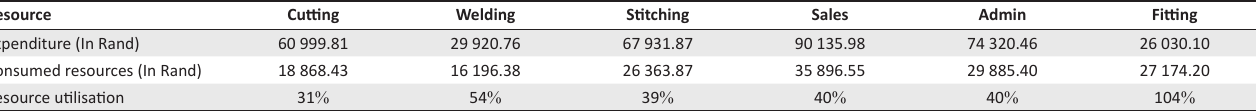
TABLE 6: Resource utilisation for the six different activities. Resource Cutting Welding